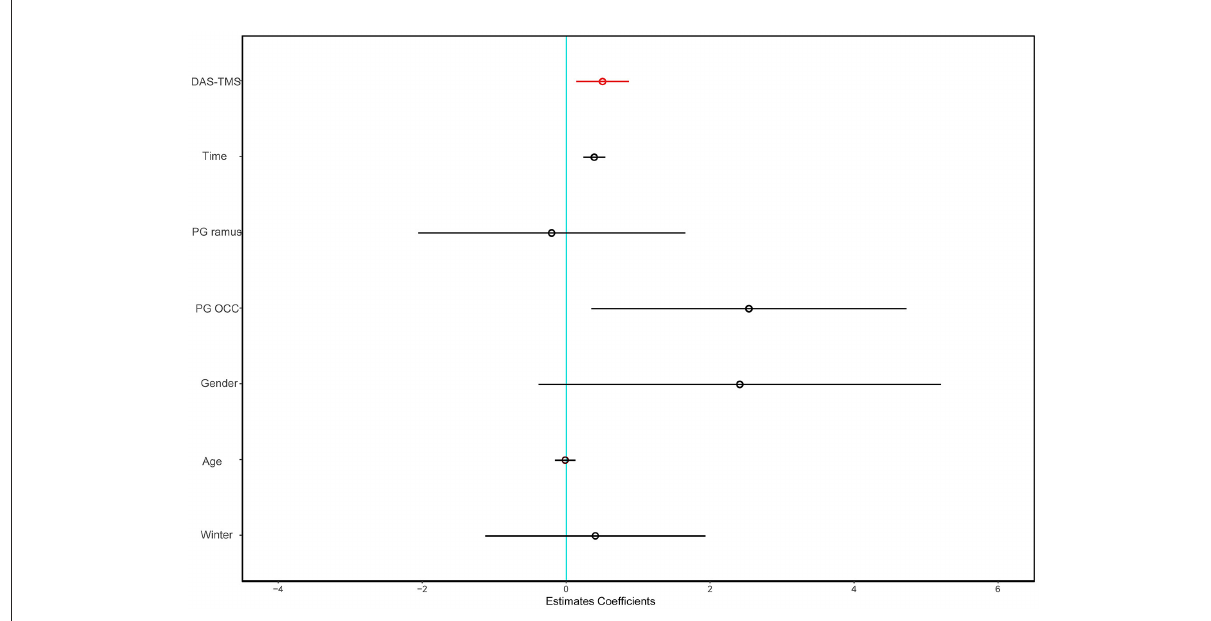
FIGURE3 The forest plot for DAS-TMS with postoperative symptoms as a continuous variable.